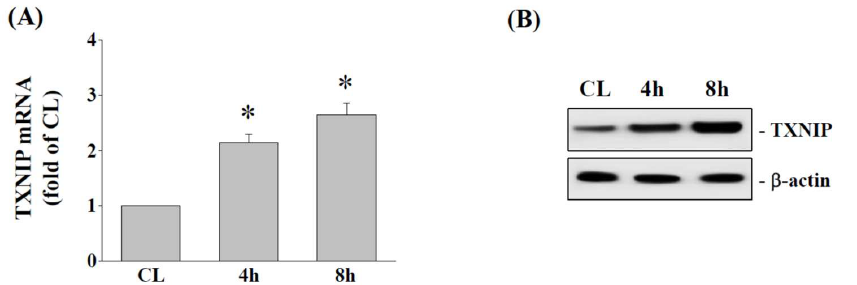
Figure 5. HCS induces TXNIP expression in HAFCs. HAFCs were exposed to 15% HCS for the indicated times, and the expression levels of ( A ) TXNIP mRNA were determined by real-time PCR analysis. The results are mean ± standard error of the mean (SEM). ( B ) The protein expressions of TXNIP were determined by Western blot analysis. Bars in ( B ) are the mean and SEM fold change in band density relative to control, normalized to total protein levels from three independent experiments. * p < 0.05 versus